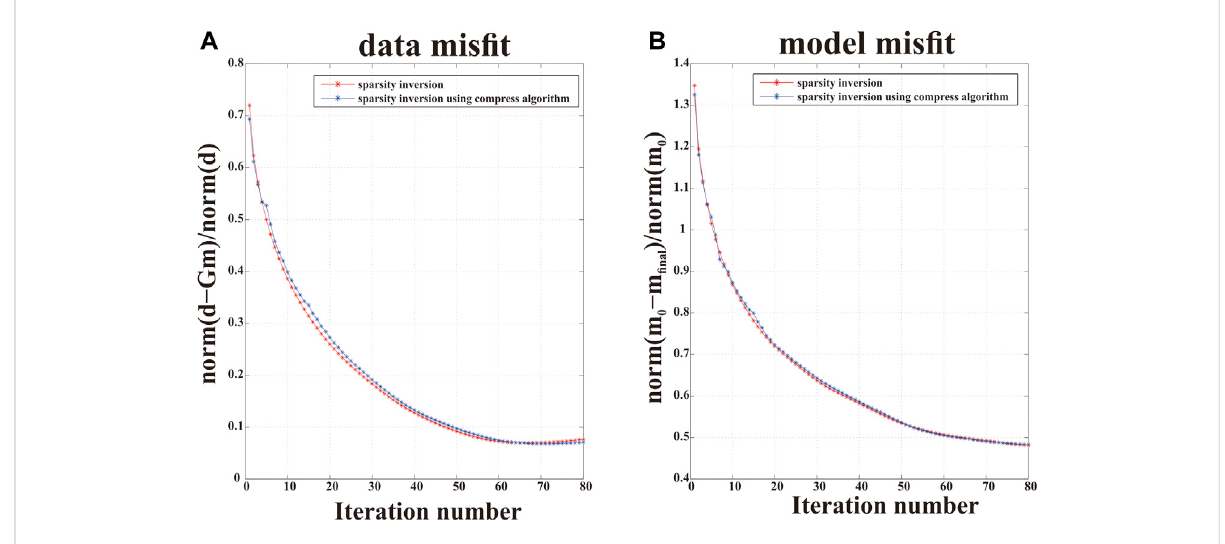
FIGURE 8 Comparison between the sparsity inversion and the sparsity inversion based on the Lanczos bidiagonalization compress algorithm; (A) trend of the data mis fi t; (B) model mis fi t generated by the difference between the two methods.